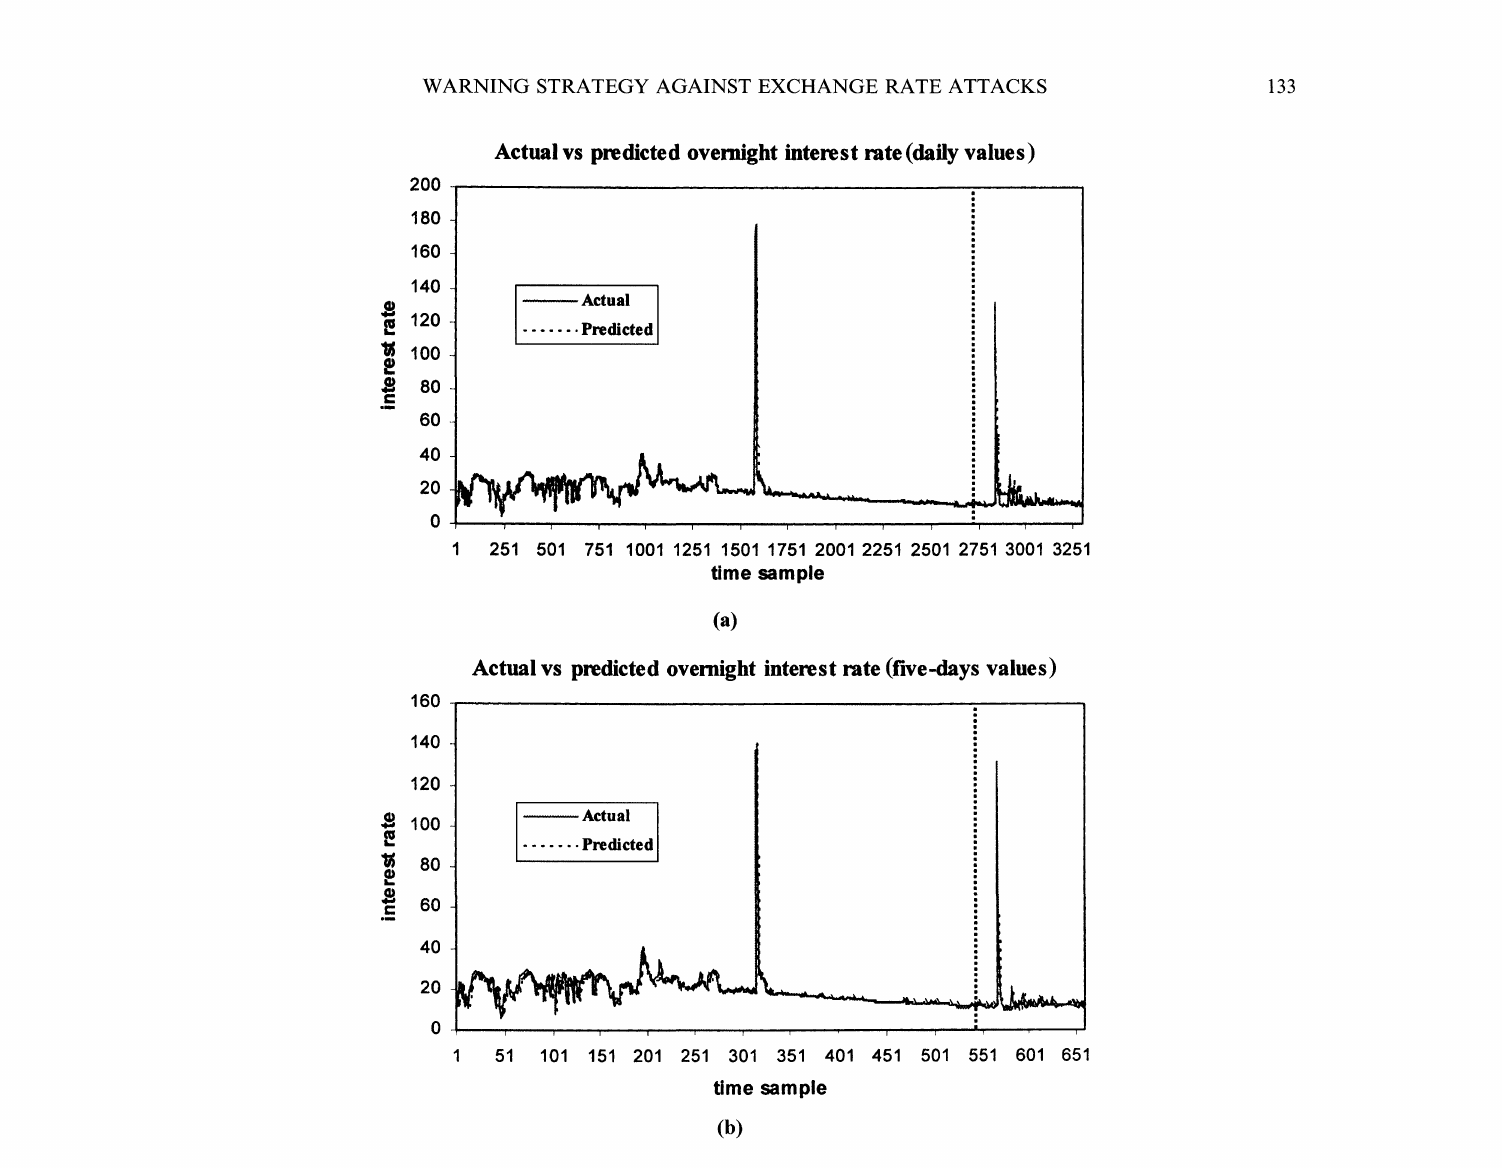
FIGURE 4 Actual versus predicted interest rate values produced by neural networks (a) MEKA, daily and (b) MLMAP, 5-days prediction